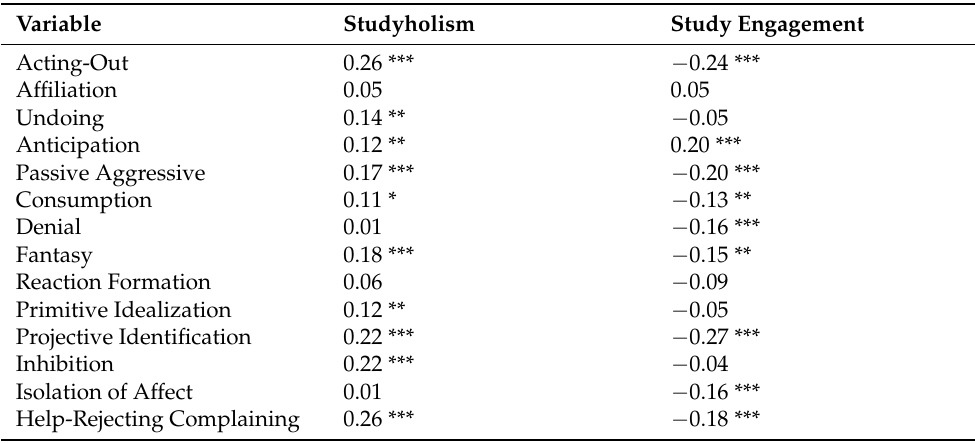
Table 2. Zero-order correlations of the study variables ( n =